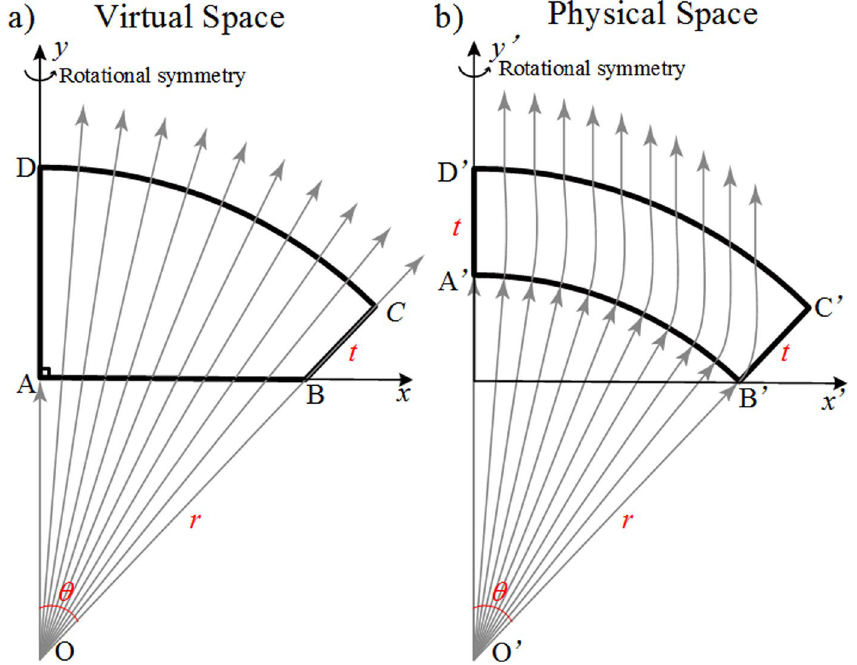
Figure 1. Illustration showing the space mapping from the virtual space to the physical space for the field shaping lens where the gray arrows represent the ray